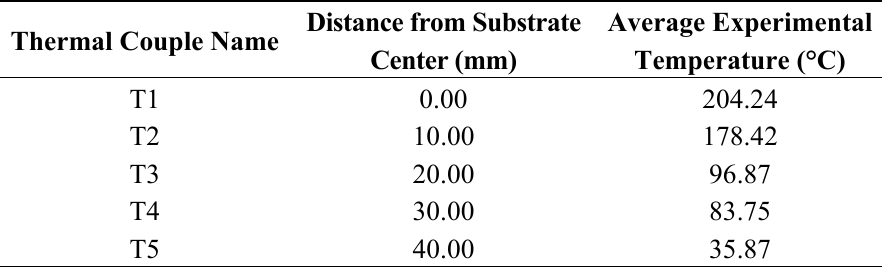
Table 3. Experimentally recorded average temperature for each thermocouple with respect to cold spray condition 1